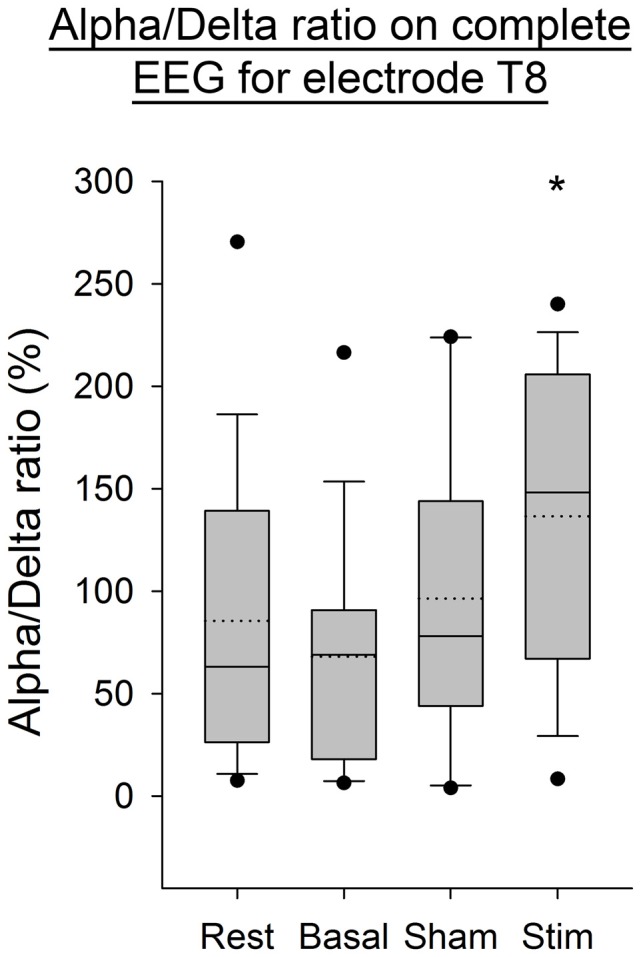
EEG Alpha/Delta ratio (complete EEG signal) for the T8 electrode for all subjects per condition. The boxes correspond to the 25–75 percentiles, the continuous lines are the median values, the dotted lines are the mean values and the whiskers represent the 10 and 90 percentiles. The dots are the outlying values. Note the increase for the stimulation condition. The Alpha/Delta ratio is expressed in percent (%), *p < 0.05 as compared to the three other conditions.